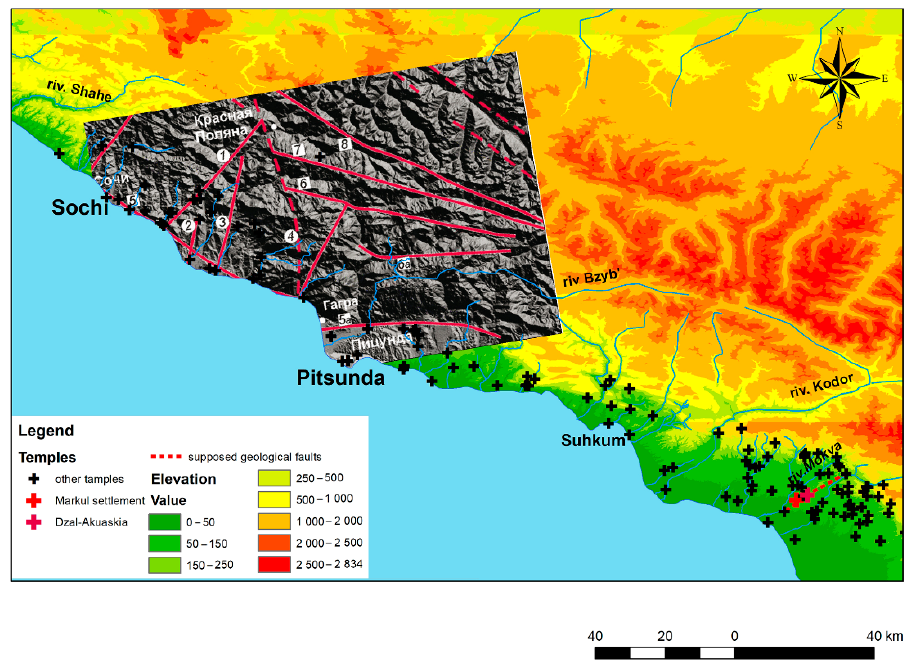
Figure 5. Synthesis of tectonic data in GIS according to the data from seismologists: The raster with red lines and numbers indicates longitudinal (5, 5a, 6, 6a, 7, 8) and transverse (1, 2, 3, 4) tectonic faults [31]; selection of faults according to our field studies (red dotted line).